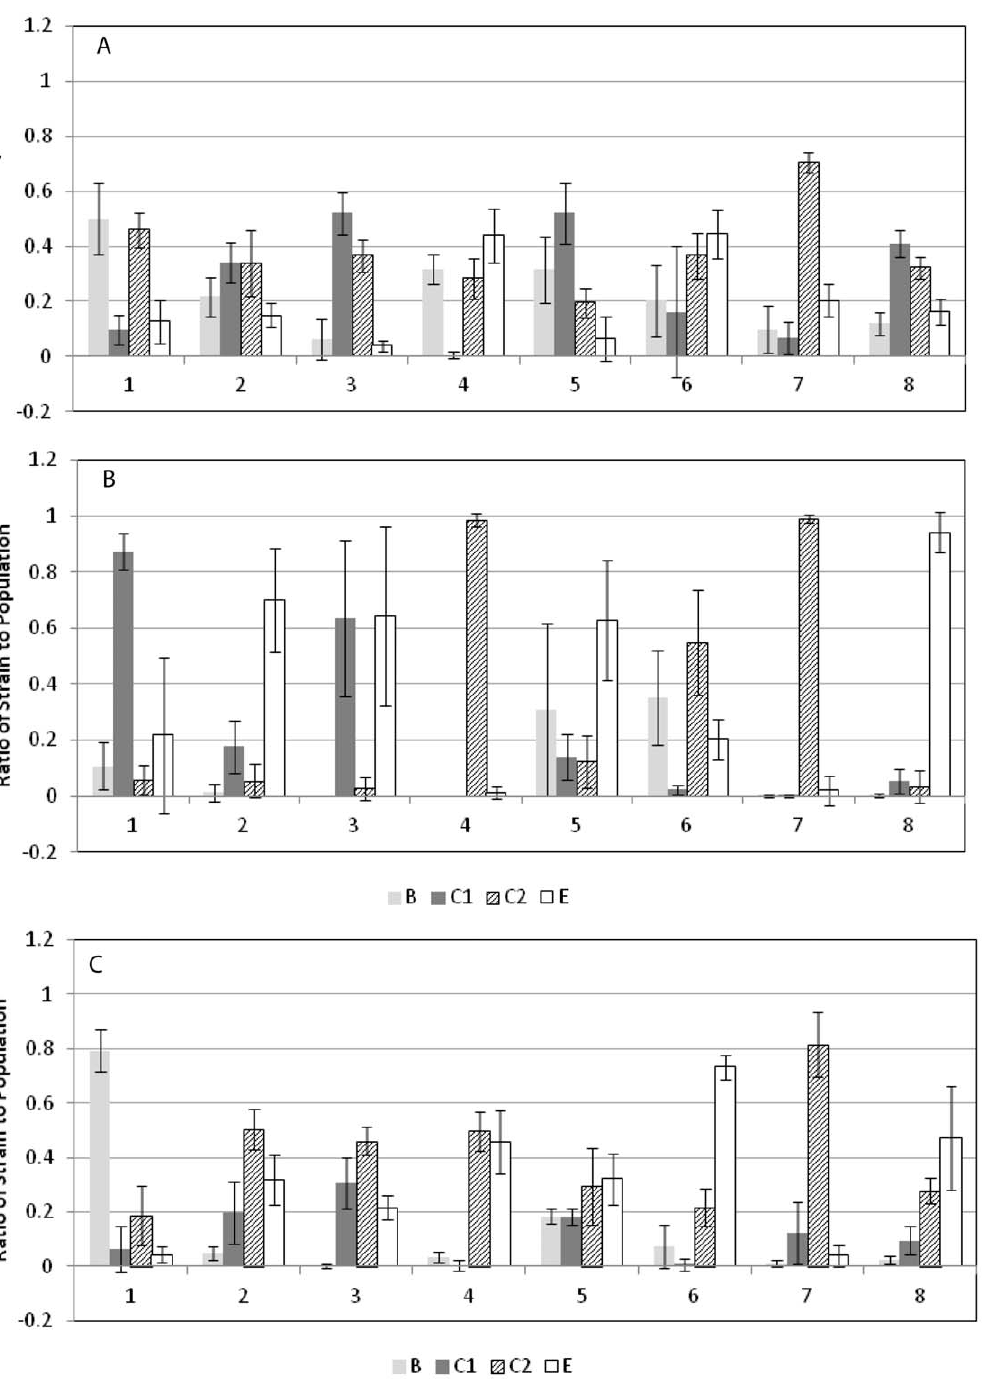
Figure 1. Ratio of each strain in the Salmonella enrichment to the whole population. (A) Ratios from the TSB mixtures plated onto TSA agar; (B) Ratios from enrichments using RV and plated onto XLD; (C) Ratios from enrichments using RVS and plated onto XLD. Values are the averages of all replicates from multiple experiments, and the error bars represent standard deviation. doi:10.1371/journal.pone.0034722.g001 group E strain RM14126 clearly dominated Mixture 6 from RVS present in very low ratios from F-RVS including many of the and F-RVS, but the rest of the mixtures showed a more equivalent serogroup B and C1 strains. Exceptions were the group B strains distribution among the co-dominant strains in the F-RVS RM2519 and RM14122 in Mixtures 1 and 4, respectively, and the enrichments. Two strains that showed less dominance in F-RVS group C1 strain RM14128 in Mixture 3, all of which were among vs RVS were the group B strain RM2519 and the group C2 strain the dominant strains in F-RVS. Group B strain RM14122 RM10604 in Mixtures 1 and 7, respectively. Some strains were (Mixture 4) performed better in the presence of the fecal